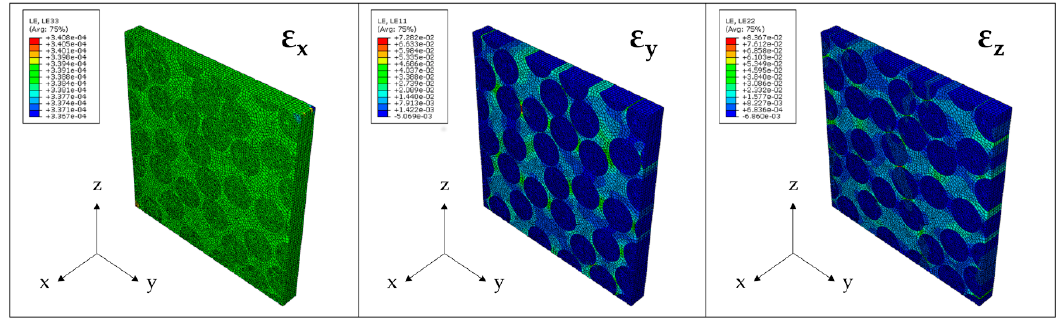
Figure 10. Swelling coefficient in axial direction, z, for the five RVEs used in the simulations.